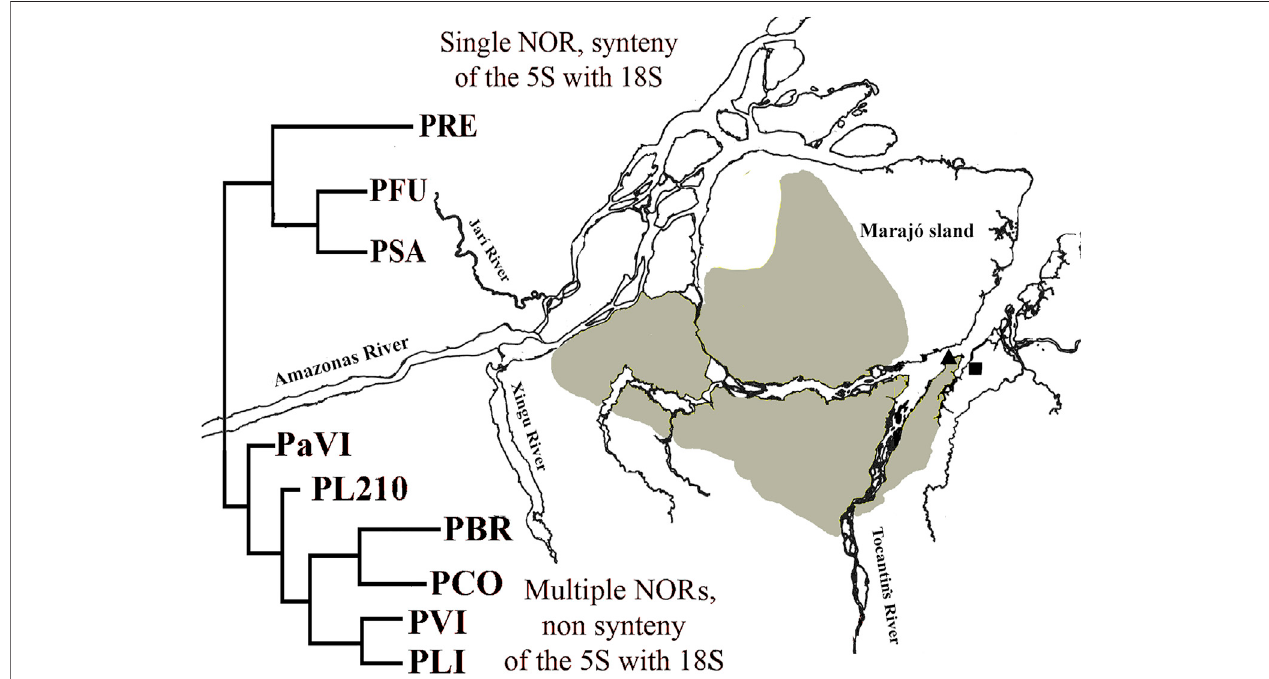
FIGURE4| MapofthemouthofAmazonRiverwithasimpli fi edversionof Peckoltia phylogeny(inred)byLujanetal.(2017).PRE: Peckoltiarelictum ;PFU: Peckoltia furcatum ; PSA: Peckoltia sabaji ; PaVI: Peckoltia aff. vittata ; PL210: Peckoltia n. sp. L210; PBR: Peckoltia braueri ; PCO: Peckoltia compta ; PVI: Peckoltia vittata ; PLI: Peckoltia lineola . Geographical location of sampling sites for Peckoltia sp. 3 Jarumã (square) and Peckoltia sp. 4 Caripetuba (triangle) in the present study. Yellow: the distribution of the Plio-Pleistocene/Pleistocene Post-Barreiras sediments (Rossetti and Valeriano, 2007).